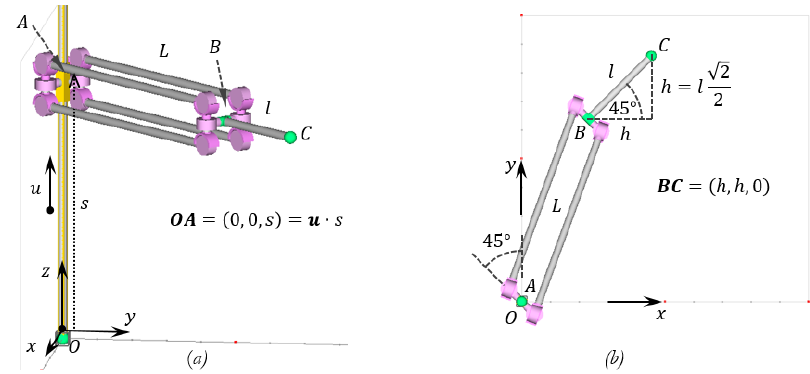
Figure 4. PPa 2 kinematic chain.